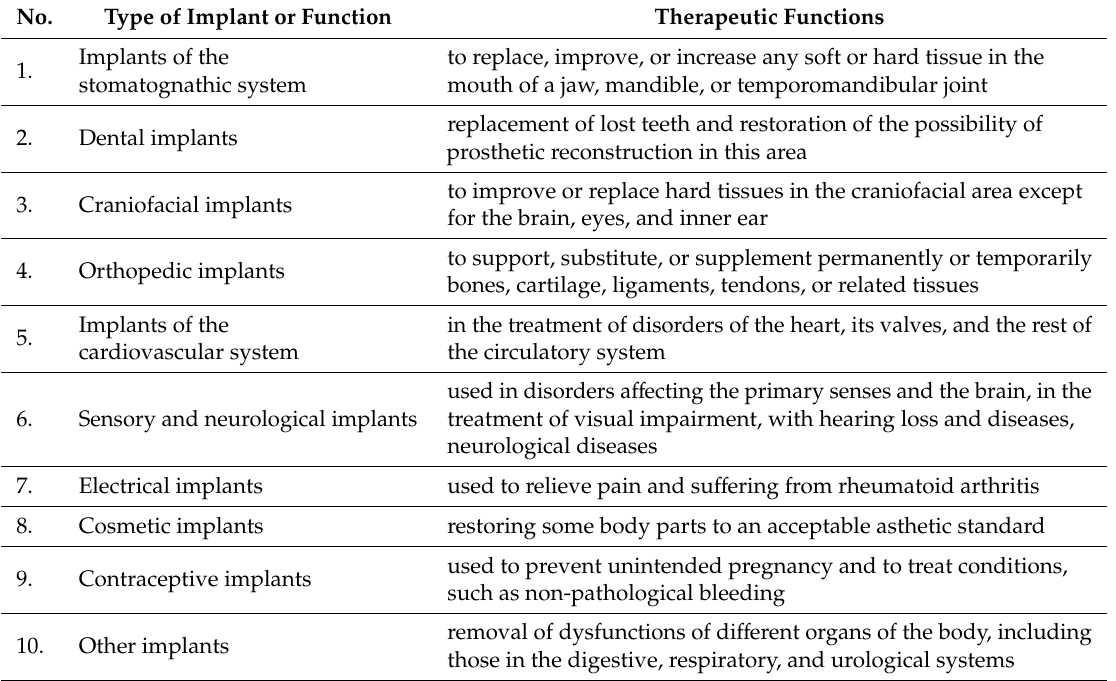
Table 1. The general classification of implants due to applications in various